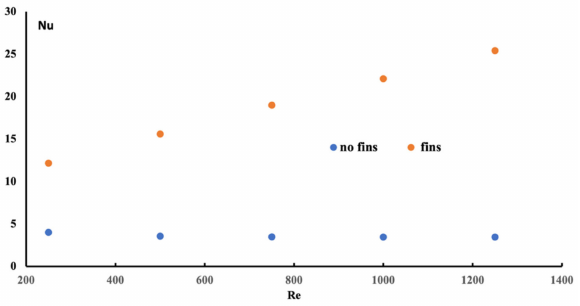
Figure 5. Effectiveness of using pin-fins along the flow path.